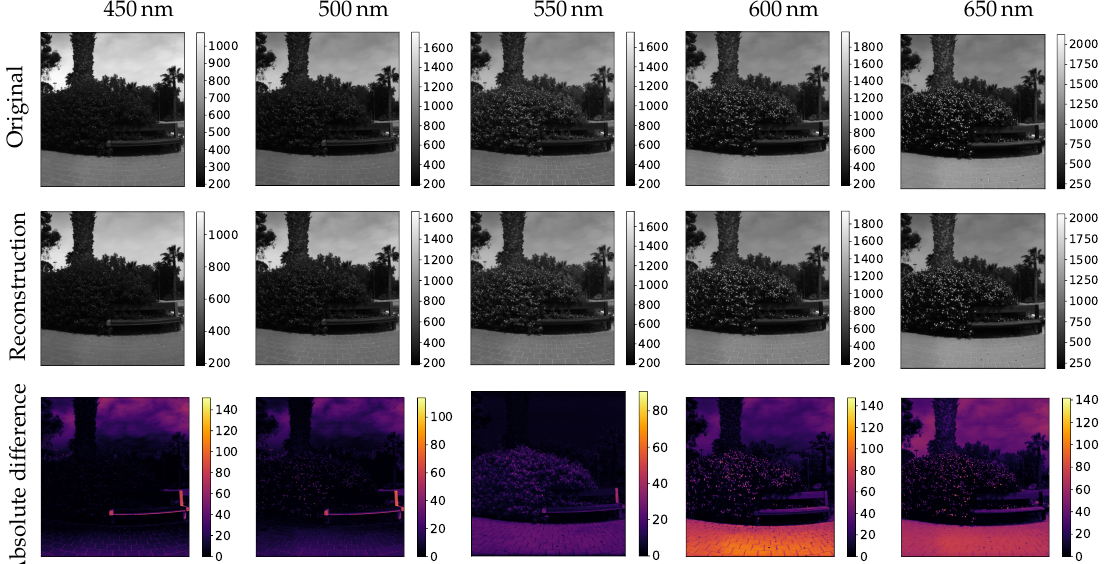
Figure 6. Five bands of an image in Outdoor scenes dataset reconstructed from learned bands by our